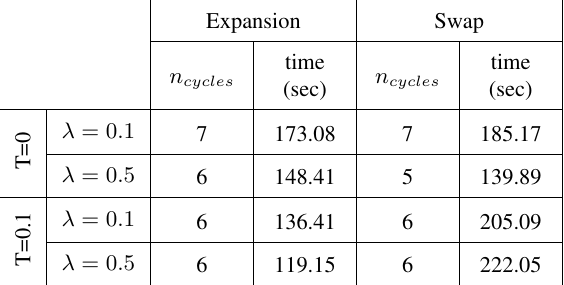
Table 1. Textured city model characteristics for α -expansion and α − β swap algorithms: Number of cycles the algorithm takes to converge ( n cycles ); Time the algorithm takes to converge in seconds.